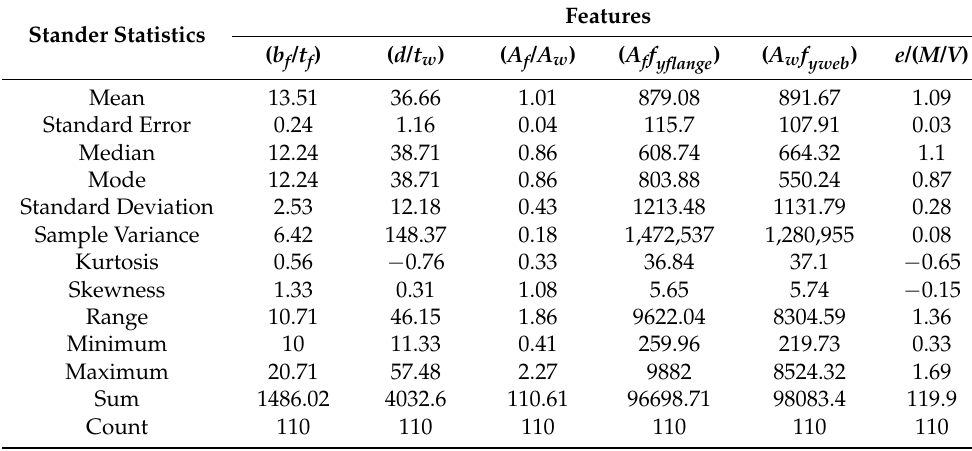
Table 3. Statistical description analysis of